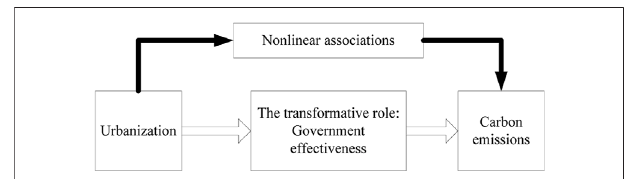
FIGURE 1 | The conceptual